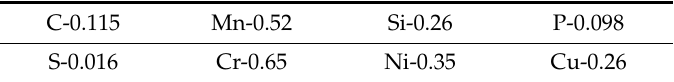
Table 1. Chemical composition of 10HNAP steel (wt %).